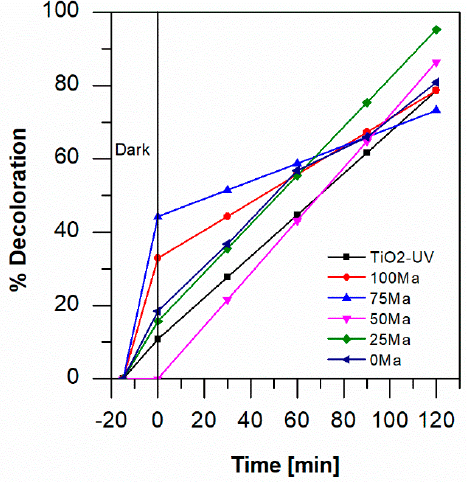
Figure 5. Percentage of degradation by photocatalysis of 1 mM of aniline blue at pH 3 with the injection of air with TiO 2 -foam / UV light and with TiO 2 -anthocyanin-foam / visible light.